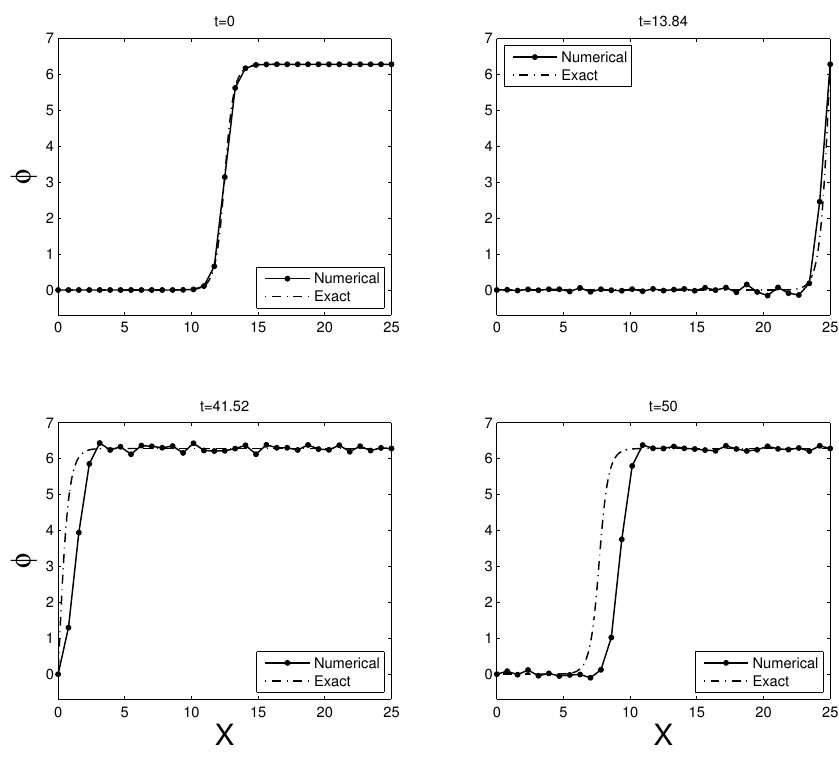
Figure 10. The single soliton solution computed on a uniform mesh with N = 31: Integration in time was performed using the 4th-order Gauss scheme. Integration with the 4th-order Lobatto IIIA–IIIB yields a very similar level of accuracy.